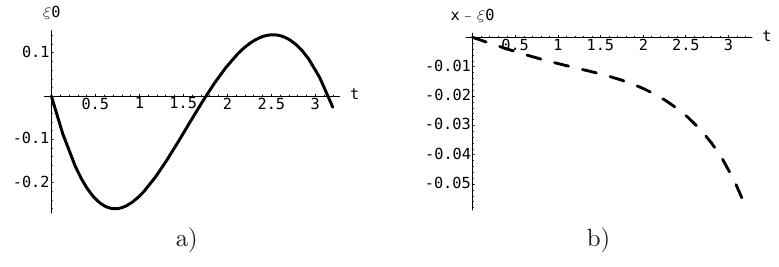
Figure 9. 0 -type solution of the problem